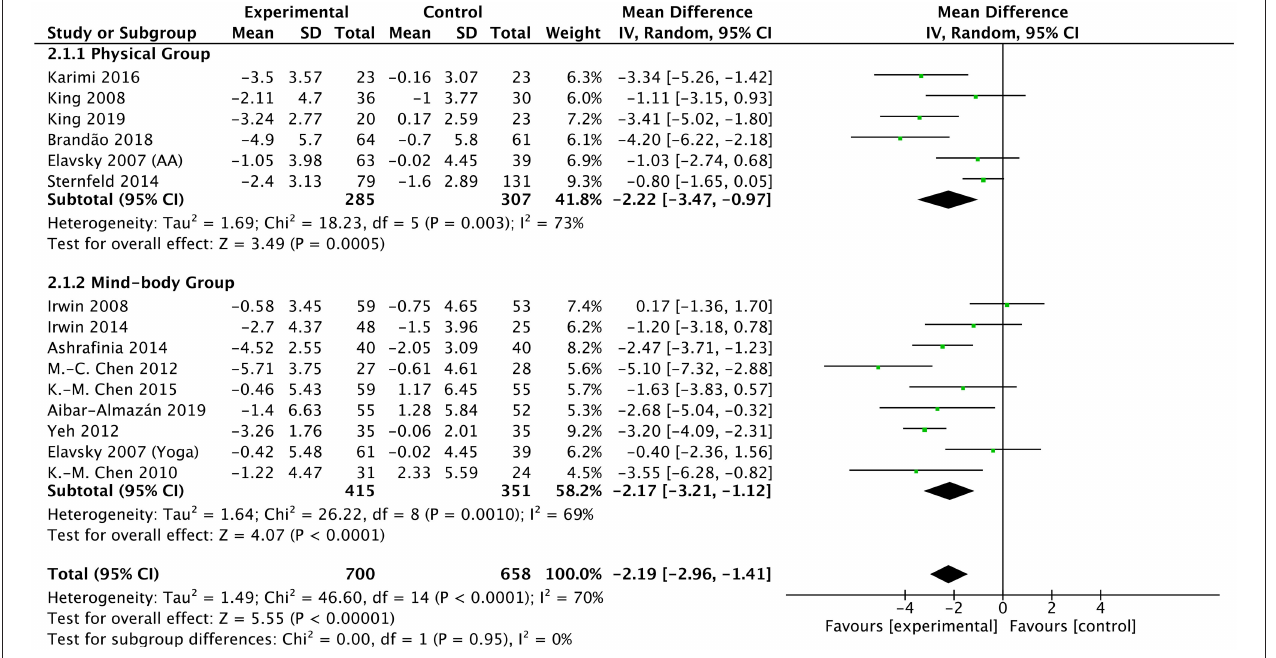
FIGURE 3 | Forest plot of PSQI scale outcomes in overall analysis and subgroup analysis stratified by the type of exercise intervention.